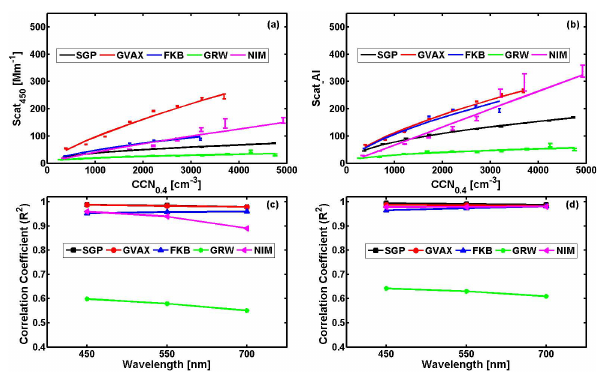
Fig. 2. Same as Fig. 1, but AOD is replaced by aerosol scattering co- efficients for dry aerosol particles with diameters of less than 1µm measured by nephelometers.